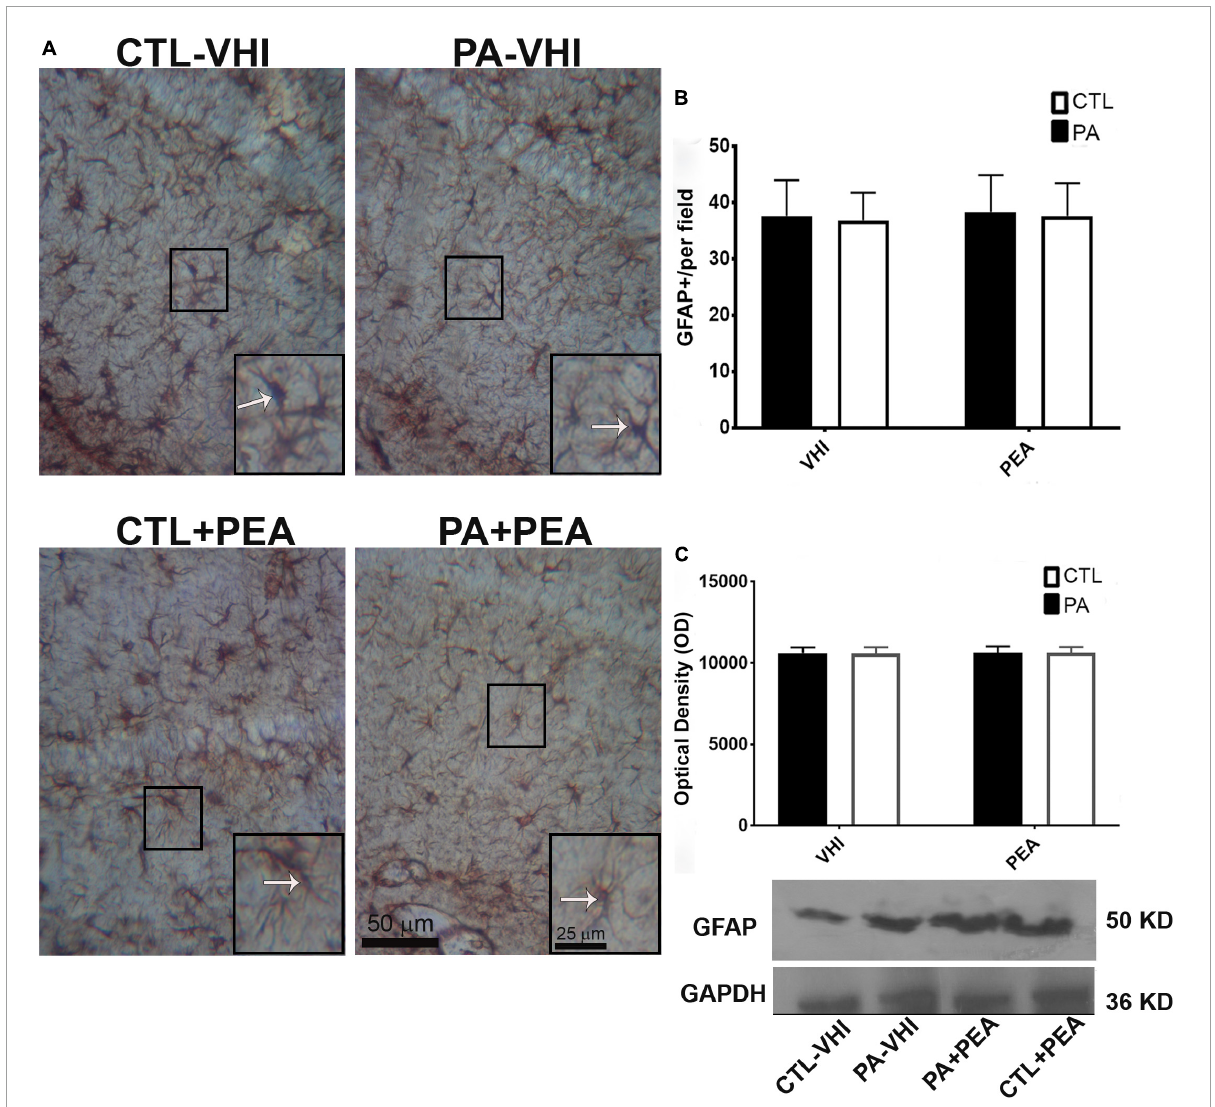
FIGURE9 Glial fibrillary acidic protein (GFAP) immunostaining and protein expression in the rat hippocampus on P21. (A) Representative images of the stratum radiatum of CA1 hippocampal area immunostained for GFAP. Scale bar: 50 µ m. Marked rectangular areas in the main-image are shown magnified in the corresponding lower right margin. The white arrow indicates positive immunostaining area for GFAP. Scale bar: 25 µ m. (B) Percentage of reactive area of GFAP positive astrocytes. (C) Optical density of bands showing GFAP protein expression in Western blot. Results are shown as mean ± SEM. CTL-VHI, control rats treated with vehicle; PA-VHI, rats subjected to PA and treated with vehicle; PA + PEA, rats subjected to PA and treated with PEA; CTL + PEA, control rats treated with